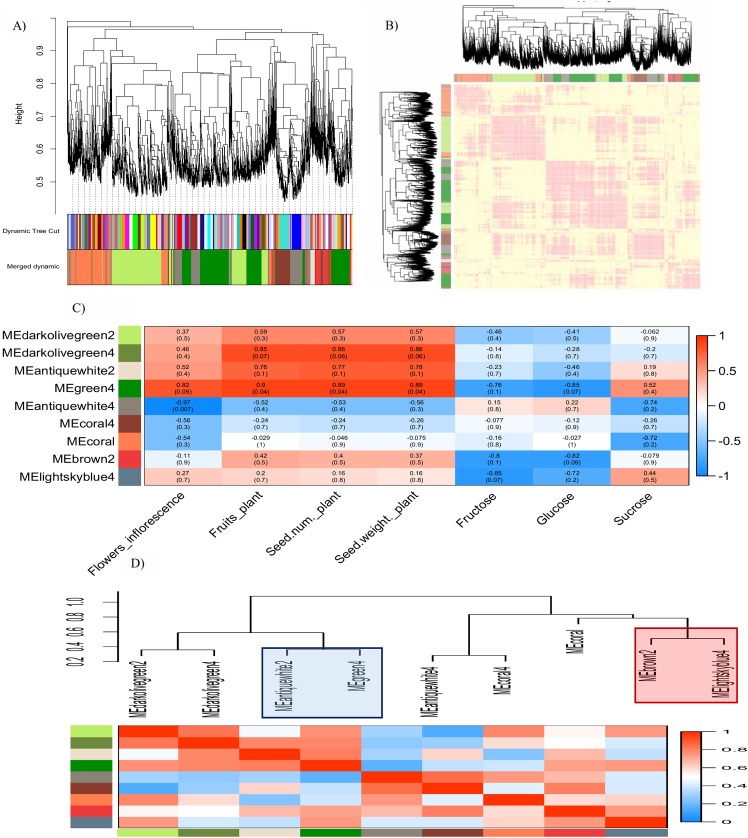
Weighted gene co-expression network analysis of RNA-seq based expression profiles of two-year-old Jatropha curcas inflorescences.A) Cluster of dendrogram indicates total number of modules under the dynamic tree cut and merged dynamic (pooled modules). B) Weighted gene co-expression network of the J. curcas inflorescence. C) Correlations between the module eigengenes and yield factors (traits); flowers per inflorescence, fruits per plant, seeds per plant, total seed weight (g) and simple soluble sugars (fructose, glucose and sucrose). Column represent the yield factors and the row represent module eigengenes (MEs). Correlation coefficient is represented by colours ranging from red (high positive correlation) to green (high negative correlation) and the corresponding p-values are presented in parentheses. D) Correlations between the MEs represented by dendrogram (top) and heatmap (bottom). Blue box and red box in the dendrogram represents cluster 1 and 2, respectively. Column and row in the heatmap represent the module colour/module identity. Correlation coefficient is represented by colours as described in C).